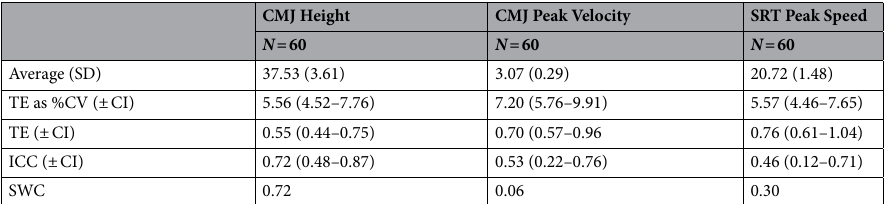
Table 3. Reliability of CMJ and SRT measures of neuromuscular fatigue. CMJ countermovement jump, SRT submaximal running test, SD standard deviation, TE typical error, CI confidence interval, CV coefficient of variation, ICC intraclass coefficient correlation, SWC smallest worthwhile